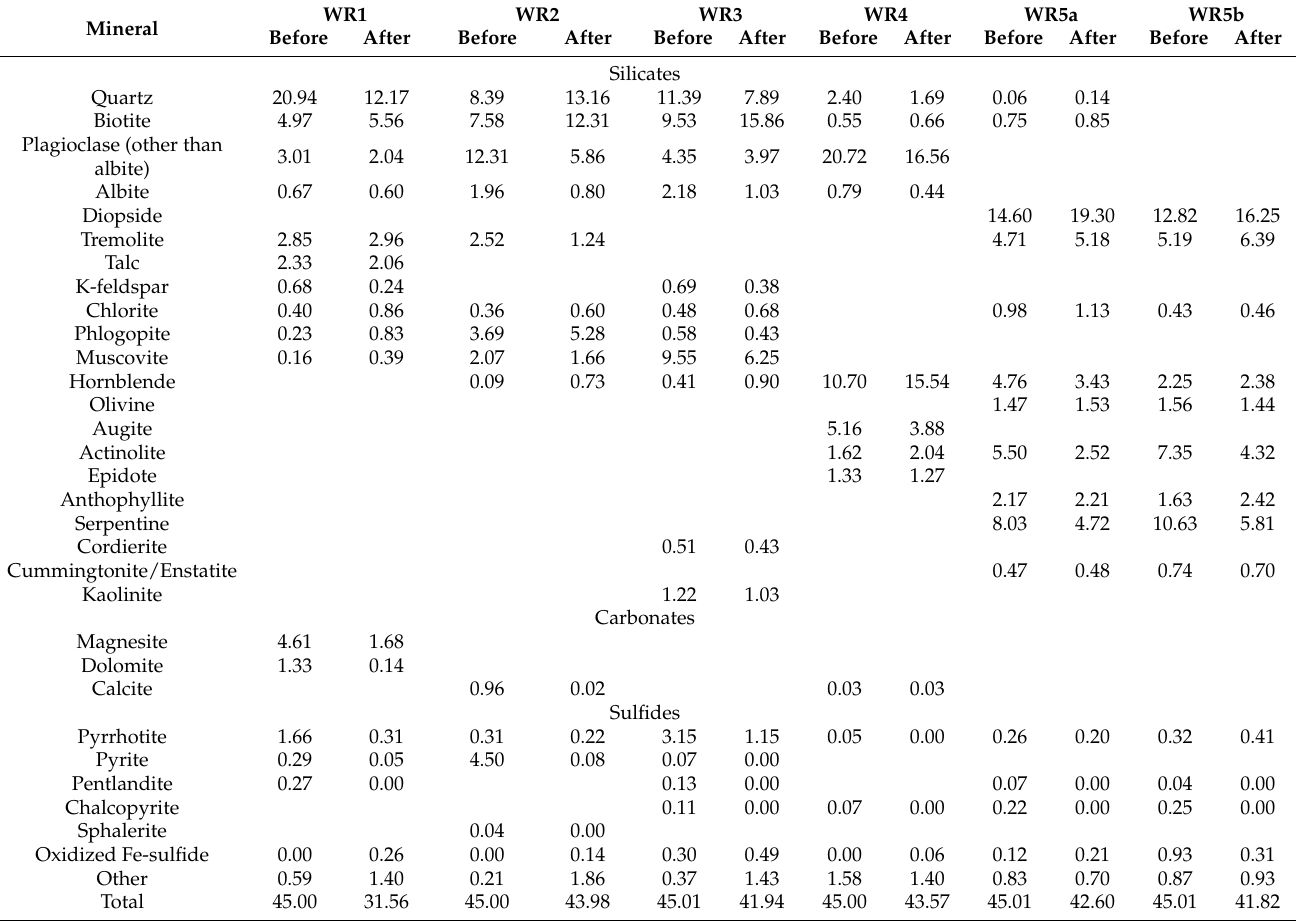
Table 2. Mineralogy of the samples before and after the HA2 extraction based on FE-SEM-EDS. Values presented as grams, mineral masses calculated with the wt. % and the total mass of the sample (g). Mineral